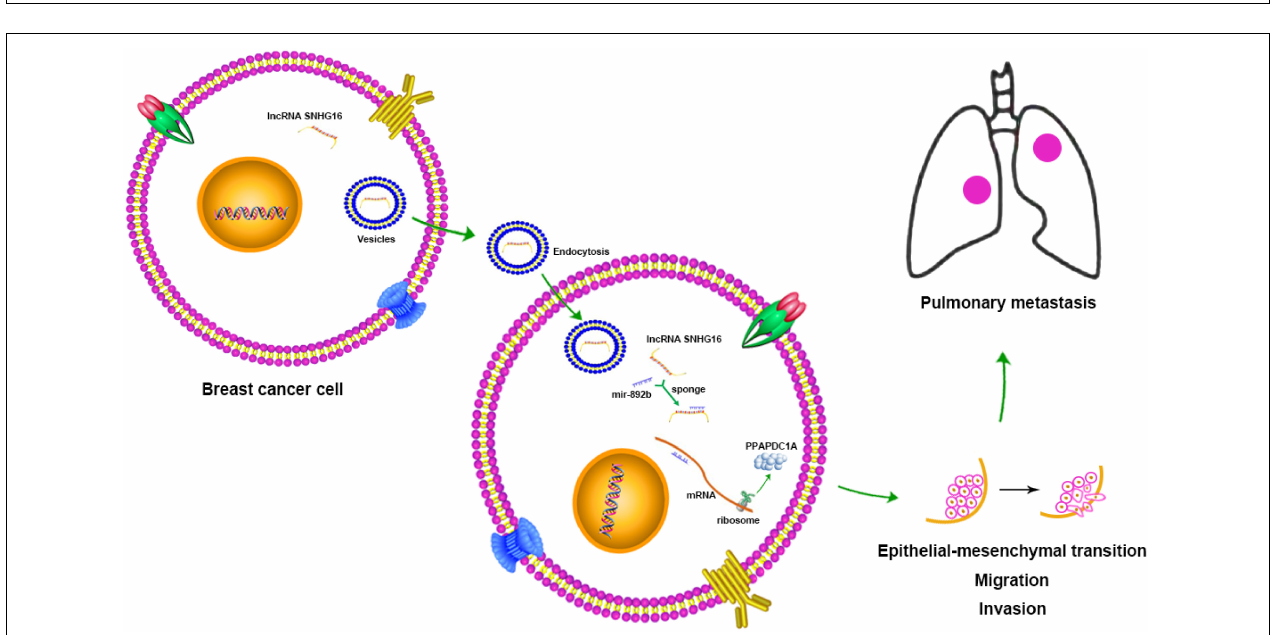
FIGURE 7 | SNHG16 carried by EVs promoted lung metastasis of BC cells in nude mice. HS578T cells were injected into mice via tail vein to establish the metastasis model. (A) Counting of metastatic lung nodules. (B) HE staining and vimentin immunohistochemical staining of metastatic lung tissues, N = 6. Data were analyzed using one-way ANOVA, followed by Tukey’s multiple comparison test, ∗ p < 0.05.